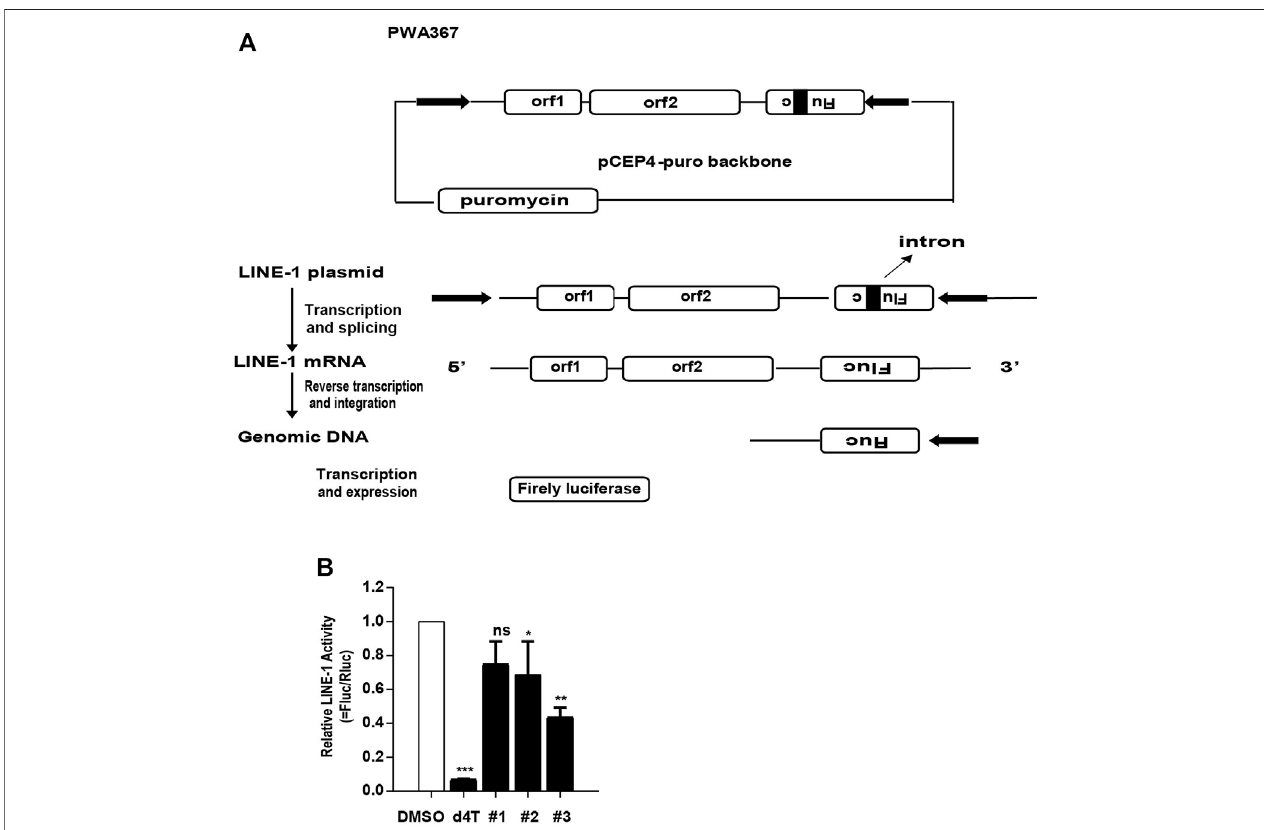
FIGURE 6 | The effect of the compounds on LINE-1 retrotransposition. (A) , Illustration of the pWA367 reporter. Following transcription from the P1 promoter of LINE-1,theintronintheFlucreportergeneisremoved.TheintronlessmRNAisthenreversetranscribedintocDNAthatisabletoproduceafunctionalFlucgenereporter mRNA. (B) , The effect of the compounds on LINE-1 mobilization. HeLa cells were transfected with pWA367 reporter DNA and then treated with #1, #2 and #3 (10 μ M) respectively. The Fluc/Rluc represent LINE-1mobilization activity. Thedata from three independent experiments were summarized in thebar graph. p -values were calculated using a standard Student ’ s t-test. * p < 0.05, ** p < 0.01, *** p < 0.001, ns, not signi fi